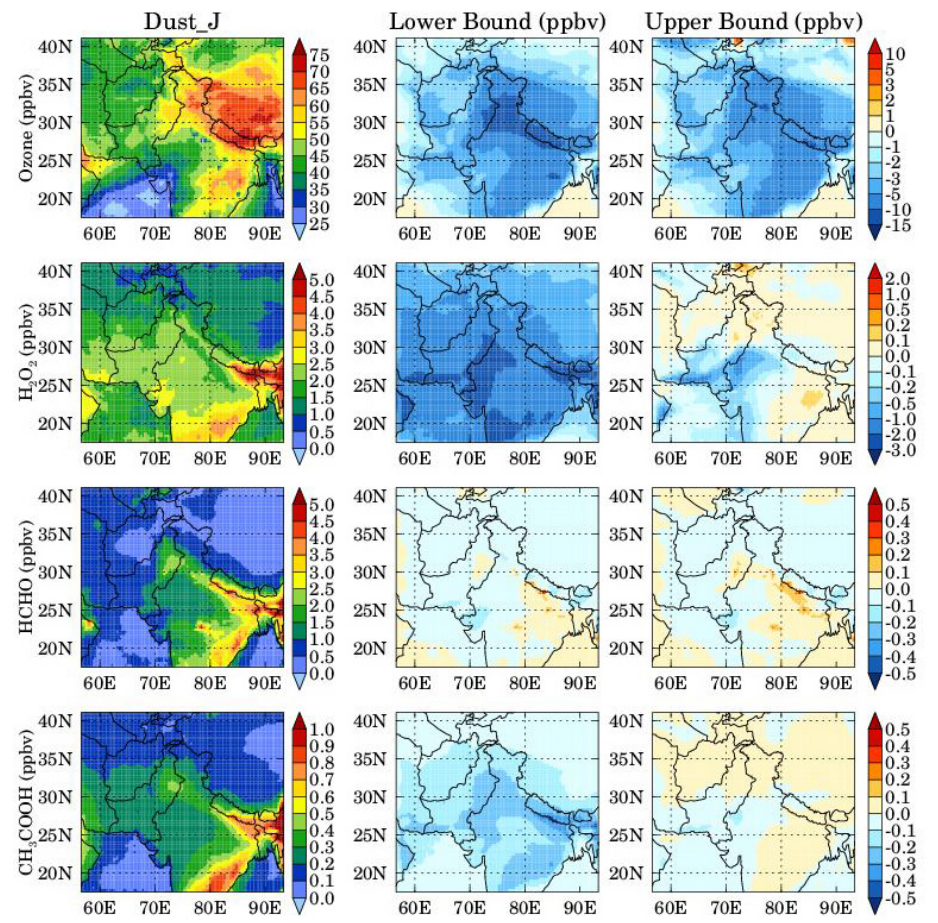
Figure 11. Spatial distributions of WRF-Chem-simulated average mass concentration of fresh and aged dust particles of 1.4µm effective radius at the surface in Dust_JH_NO 3 , Dust_JH_SO 4 and Dust_JH_NO 3 _SO 4 configurations during 17–22 April 2010. 1 O 3 is calculated by subtracting the average surface O 3 in Dust_JH configuration from the corresponding average values in Dust_JH_NO 3 , Dust_JH_SO 4 and Dust_JH_NO 3 _SO 4 configurations